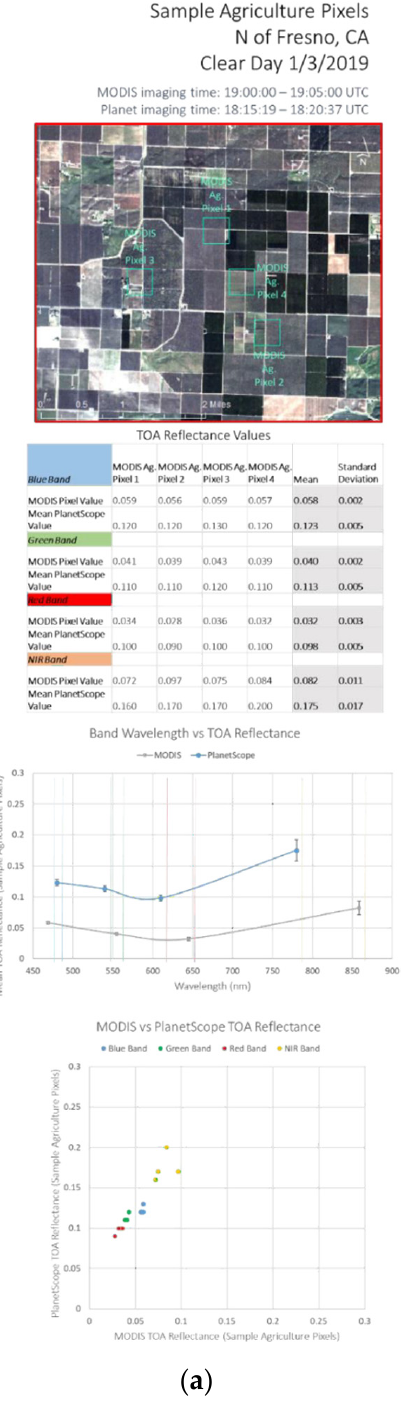
Figure 4. Comparison of results for ( a ) a clear day (1/3/2019); ( b ) and a hazy day (8/7/2018) for agriculture pixels sampled near Fresno, CA. Results for other land cover types sampled in the Fresno and Los Angeles study areas can be found in Appendix A Figures A1–A5.